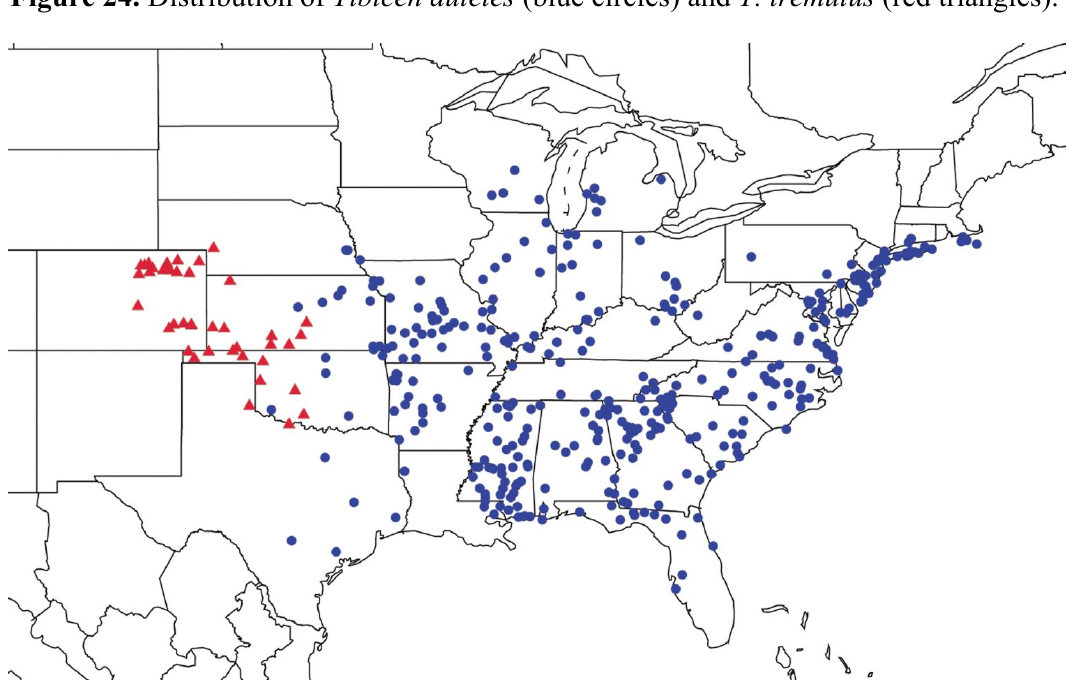
Figure 24. Distribution of Tibicen auletes (blue circles) and T. tremulus (red